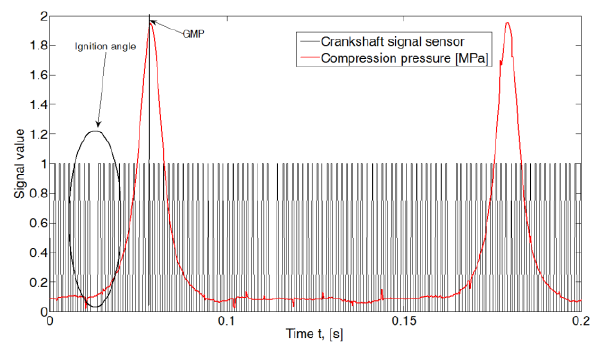
Fig.11 Course of pressure increase in